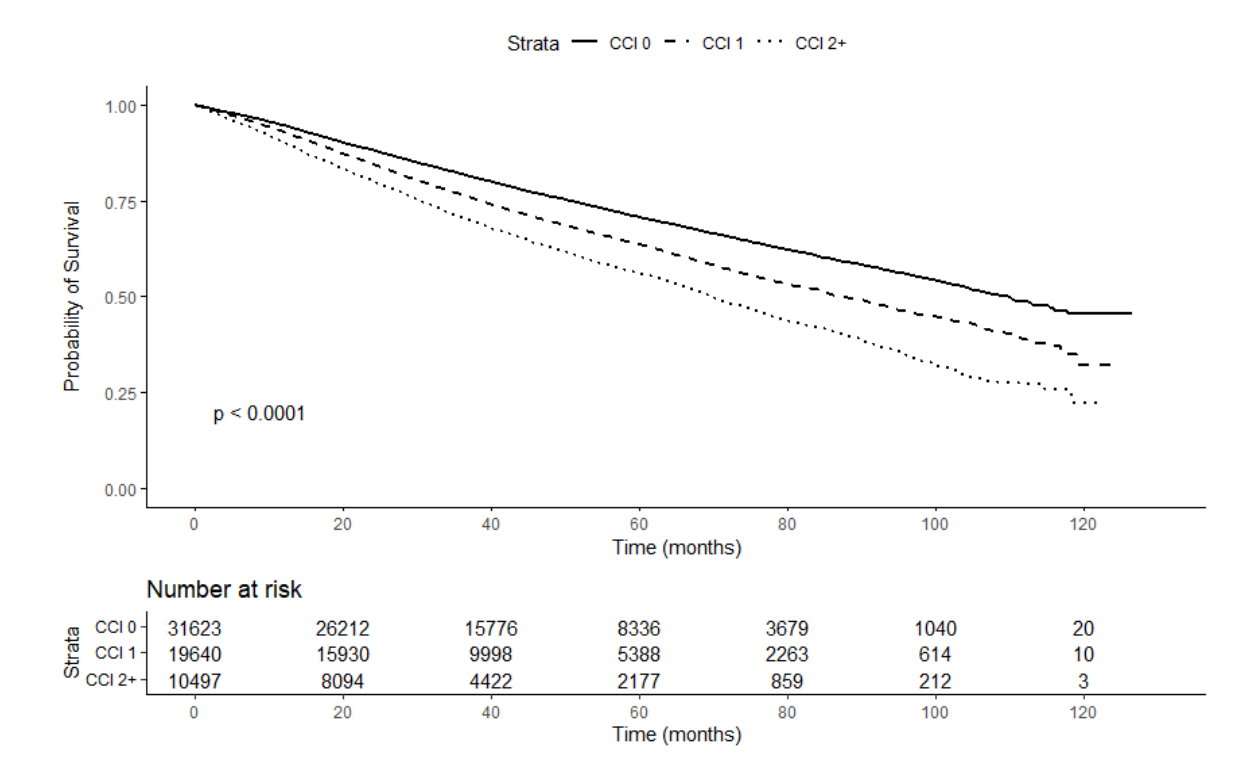
Figure 2. Kaplan–Meier survival curve stratified by CCI. Table 2. Association of all-cause mortality with CCI in stage I-II NSCLC patients undergoing thora- coscopic resection (N = 61,760).